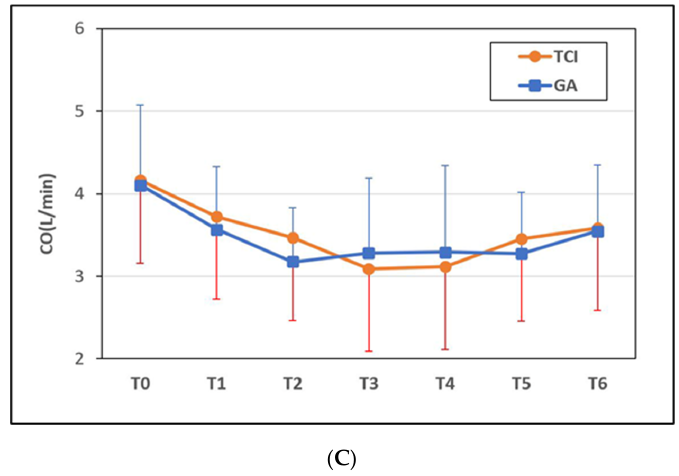
Figure 2. Time course of perioperative hemodynamic change. ( A ) Mean arterial pressure (MAP) change %, ( B ) heart rate (HR) bpm, and ( C ) cardiac output (CO) L/min. The TCI Group had less mean arterial pressure fluctuation than the GA group ( p < 0.05 during T2~T4). There was no significant difference in the change in heart rate and cardiac output between groups. Time intervals were defined as follows: T0 (pre-induction), T1 (post-induction), T2 (first surgical incision), T3 (15 min after first surgical incision), T4 (subcutaneous tunneling), T5 (wound closure), T6 (the end of surgery), and T7 (arrival at Post-Anesthesia Care Unit). GA = general anesthesia with sevoflurane, TCI = propofol target-controlled infusion. * p < 0.05, ** p < Table 2. Intra-operative events and recovery profile.